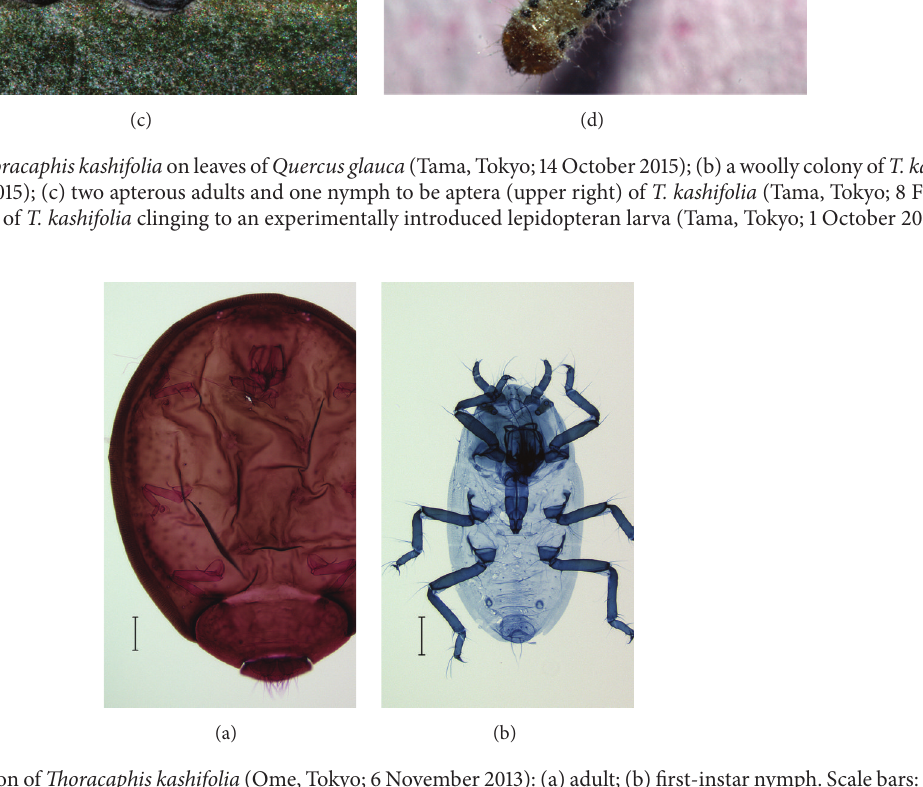
Figure 2: Apterous generation of Thoracaphis kashifolia (Ome, Tokyo; 6 November 2013): (a) adult; (b) first-instar nymph. Scale bars: 100 𝜇